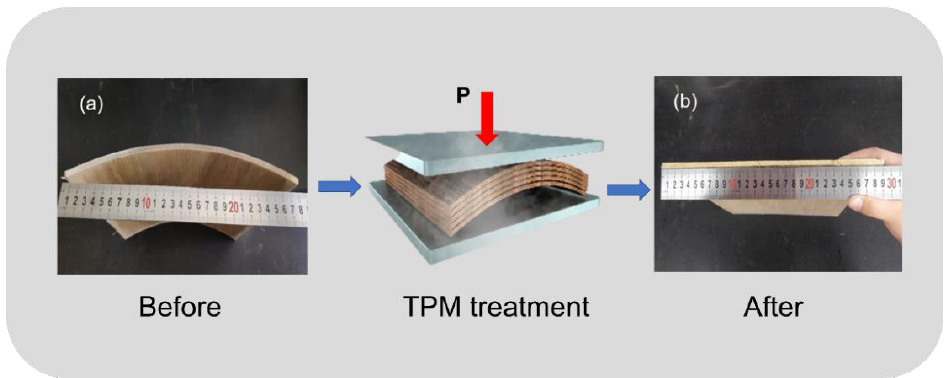
Figure 1. Thermophysical molding treatment on thick veneer: ( a ) untreated sample and ( b ) treated